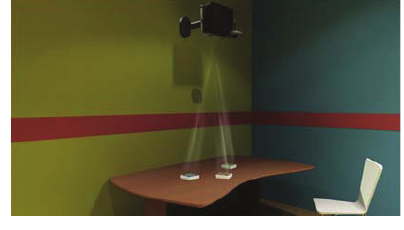
Figure 7. Conceptual image of ARBlocks platform.